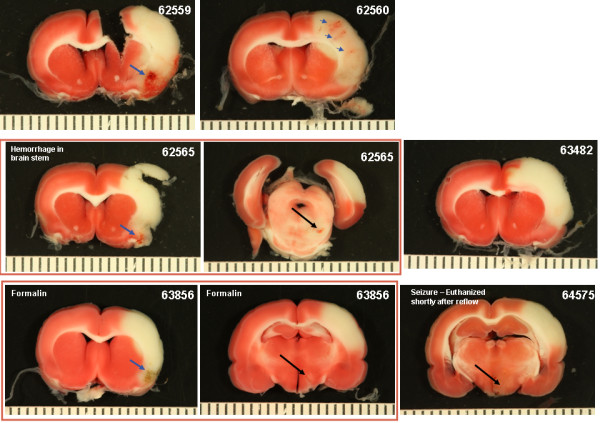
Temporal progression of the infarct volume. Rats were exposed to the designated duration of MCAo. All rats were euthanized 24 hours after MCAo onset to allow the infarct to mature. Statistics: Groups with like letters are not significantly different (p < 0.05; ANOVA, Tukey-Kramer HSD). Group values are the mean ± SEM.